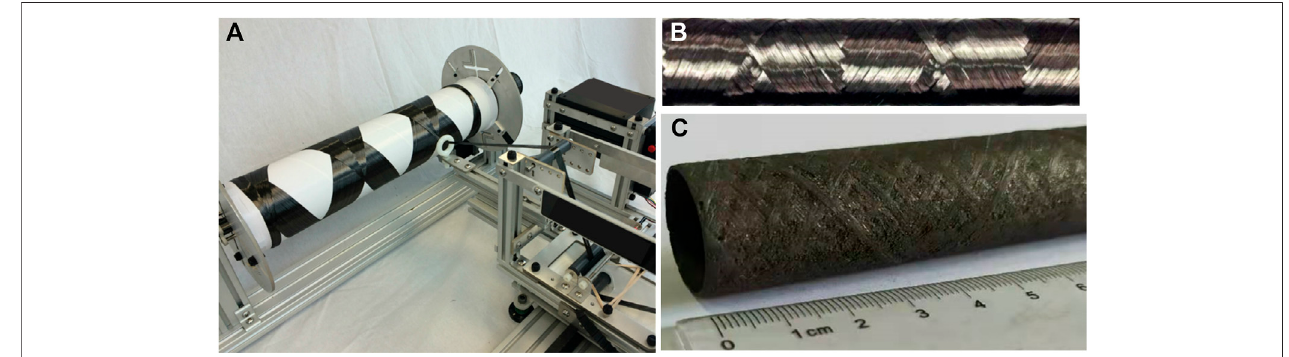
FIGURE 1 | The fi lament winding technique for nuclear fuelcladding tube. (A) Filament winding process on a 4-axis fi lament winding machine. (B) SiC fi ber wound preform (Kim et al., 2015a); (C) SiC f /SiC nuclear fuel cladding tube.